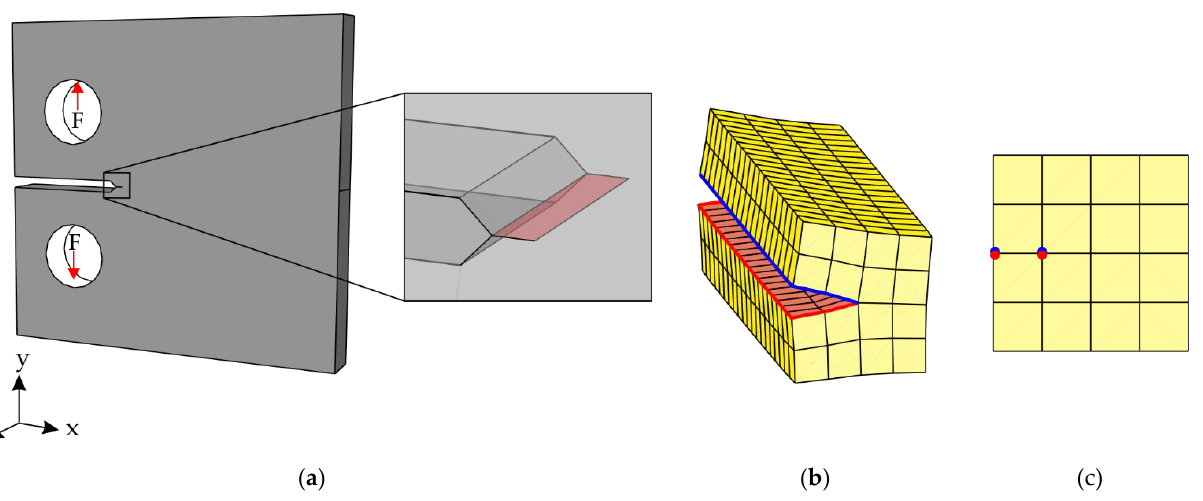
Figure 7. Models of CT specimen and the submodel for crack growth simulation: ( a ) Input model of the CT specimen along with the initial crack; ( b ) The submodel generated by Adapcrack3D with the edges of the crack surfaces marked in red and blue; ( c ) The submodel created by Adapcrack3D with the nodes on crack surfaces lying on top of each other.